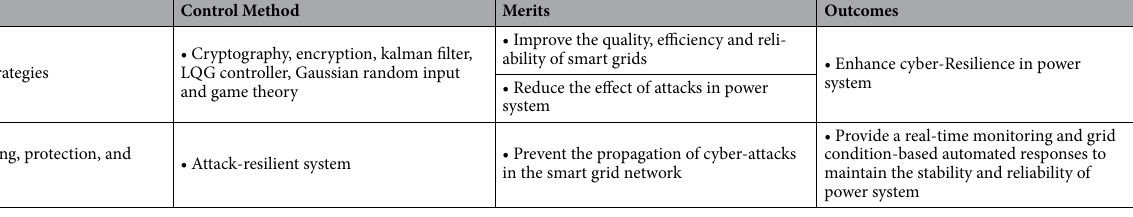
Table 5. Smart grid and microgrid